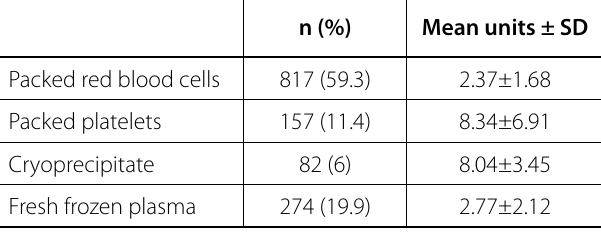
Fig. 1 - Outcomes in patients with EuroSCORE ≤ 2.